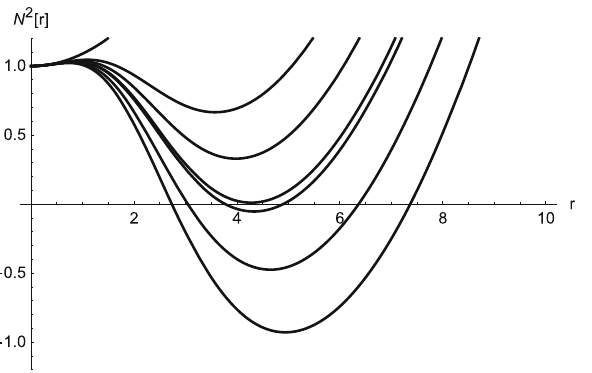
Fig. 2 The metric function N 2 ( r ) from (45). Curves are displayed by increasingthechargeparameterfromtheuppercurvetothelowercurve. We assumed ˜ q = 0, 1 . 20, 1 . 45, 1 . 66, 1 . 70, 1 . 95 and 2 . 20, λ = − 0 . 09 and ˜ a = 0 . 91. The case ˜ q = 0 corresponds to the parabola in the left upper